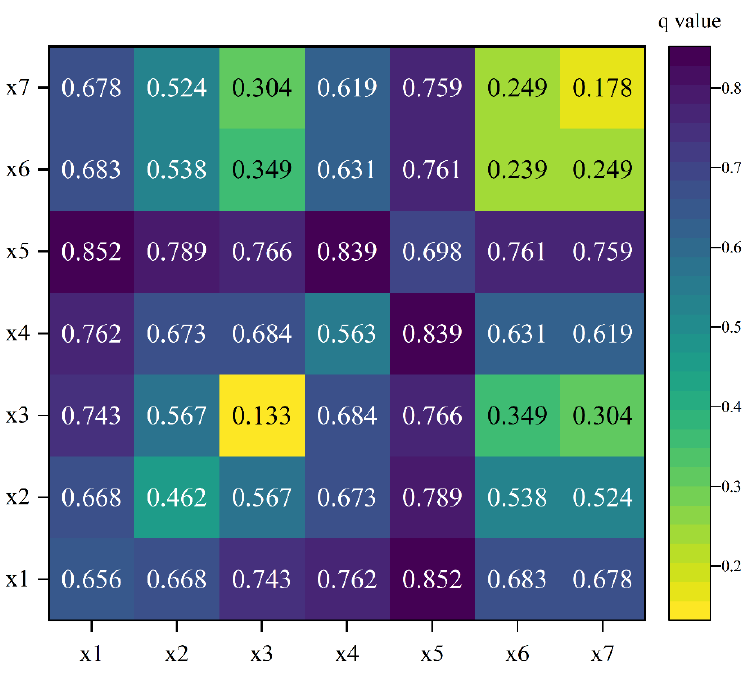
Figure 6. Interaction results of driving factors.